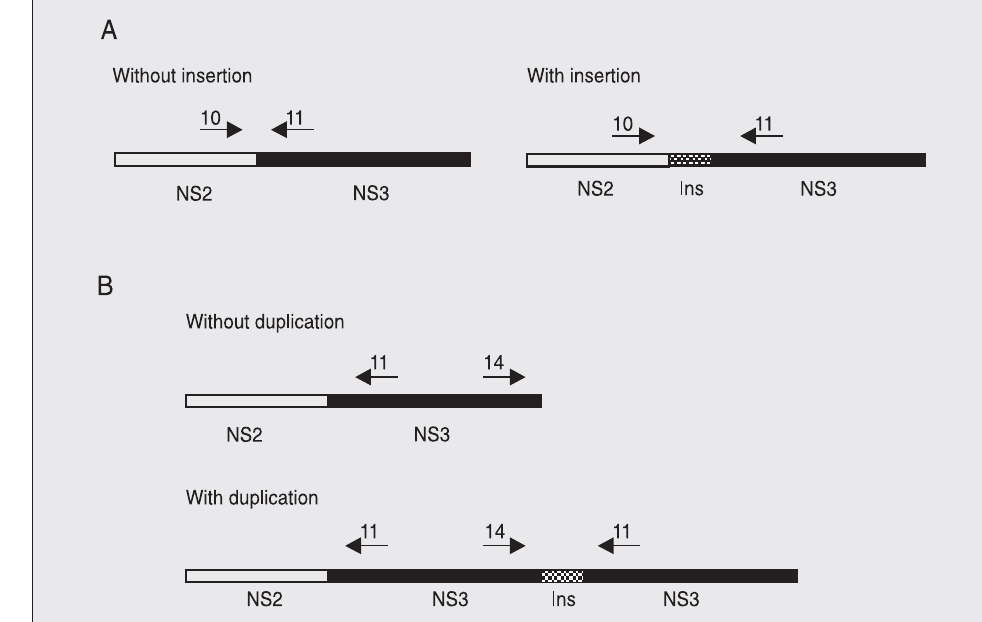
Figure 2. RT-PCR strategy used for the detection of rearrange- ments in the bovine viral diar- rhea virus (BVDV) genome. A , Detection of possible RNA in- sertions at the junction